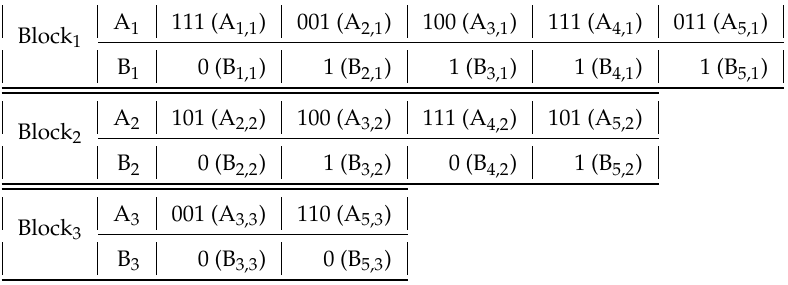
Figure 5. Organization of 3 DACs